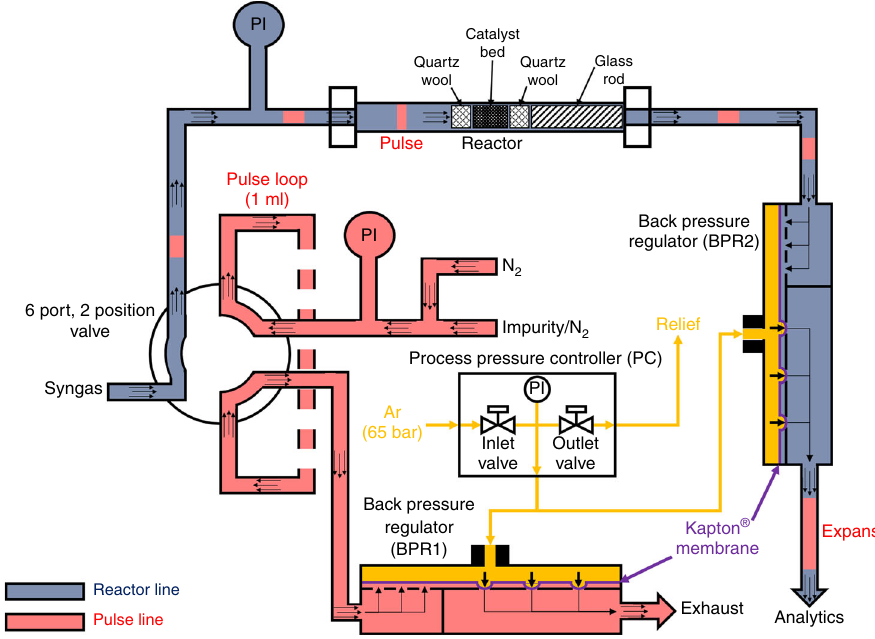
Fig. 5 Scheme of the high-pressure pulse unit integrated in the fl ow set-up. PI is de fi ned as pressure sensor in the corresponding line. The area in blue describes the fl ow direction of the syngas mixture, the red area of the injected impurities and the orange area of the reference gas (Ar) for pressure